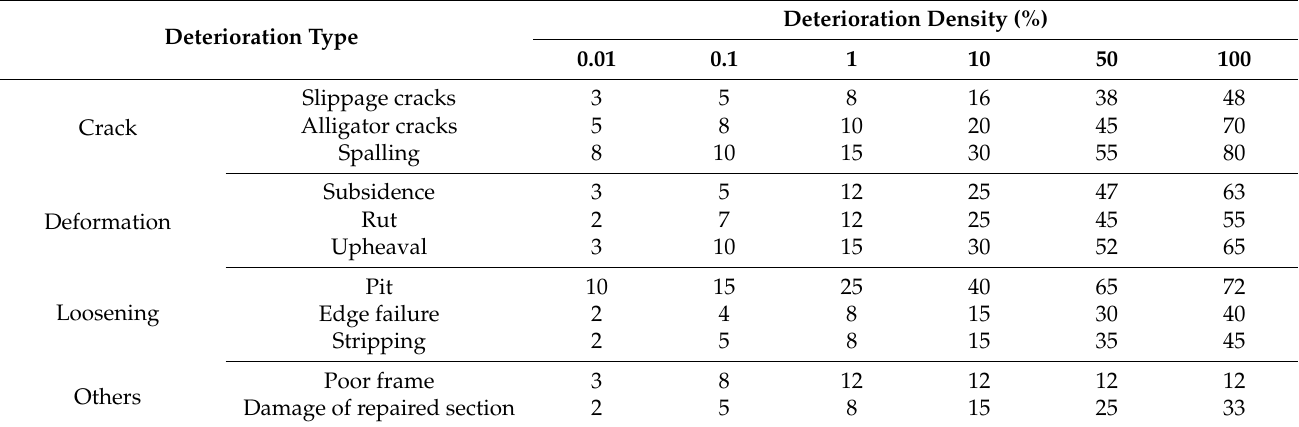
Table 1. Deductions from pavement condition index (PCI) associated with different subtypes of deterioration on asphalt pavement.